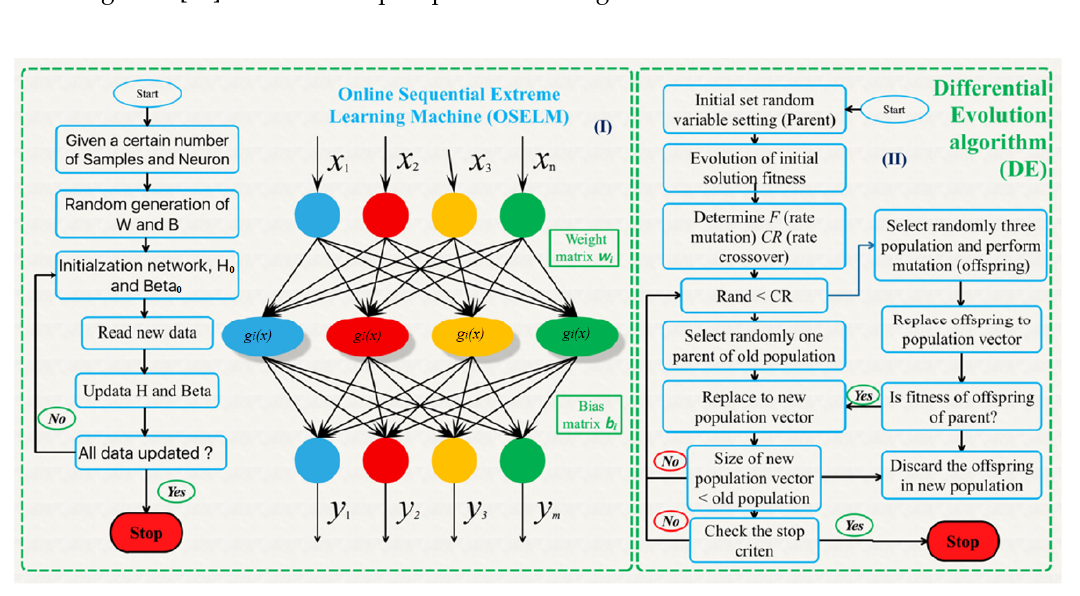
Figure 5. The flow chart of DE-OSELM [56].